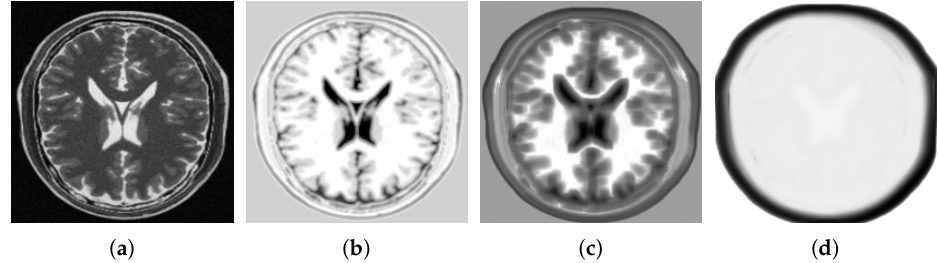
Figure 5. ( a ) A slice of T2-MRI image and it’s image representation of the embedded manifold with: ( b ) D = 9; ( c ) D = 49; and ( d ) D = 225. The higher the D , the more blurred/general structural